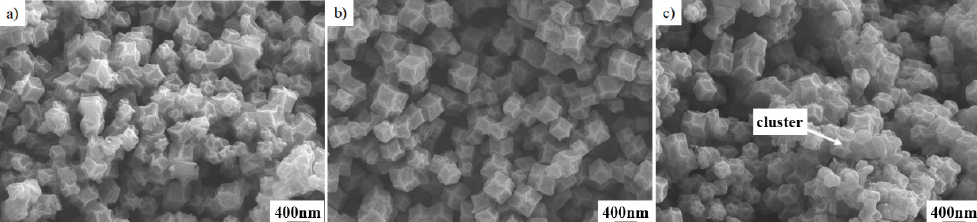
Figure 3. ( a ) The microstructure of Co–ZIF–8 pyrolyzed at 800 °C, ( b ) The microstructure of Co–ZIF–8 pyrolyzed at 900 °C, ( c ) The microstructure of Co–ZIF–8 pyrolyzed at 1000 °C.